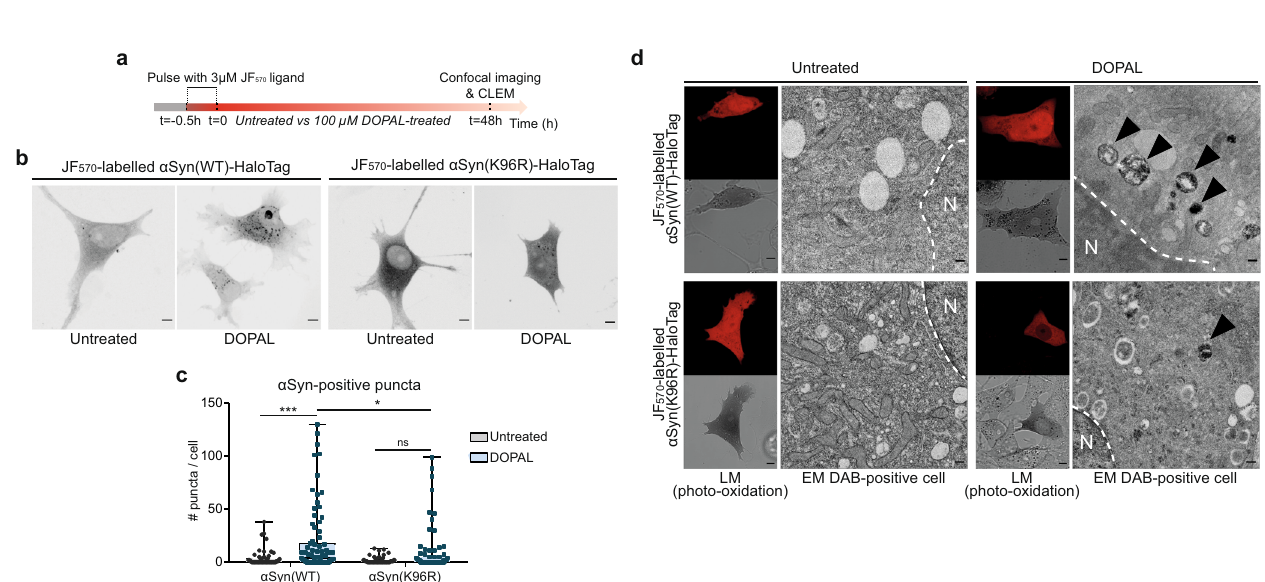
Fig. 5 K96 is required for DOPAL- α Synuclein endo-lysosomal degradation. a Schematic representation of the pulse-chase experiment using the fl uorescent JF 570 HaloTag ligand in α Syn-HaloTag-overexpressing BE(2)-M17 cells. b Representative confocal images of BE(2)-M17 cells expressing α Syn(WT)-HaloTag and α Syn(K96R)-HaloTag, labeled with JF 570 HaloTag ligand, in untreated and 100 μ M DOPAL-treated cells for 48 h. Scale bar: 5 μ m. c Incidence of α Syn-positive cytoplasmic puncta. Data from three independent experiments are pooled together and analyzed by Two-way ANOVA with Sidak ’ s multiple comparison test (* p < 0.05, *** p < 0.001). Data are displayed as box and whiskers plot showing the minimum and maximum points (whiskers), the fi rst quartile, median and third quartile (box lines). d CLEM of BE(2)-M17 cells expressing α Syn(WT)-HaloTag and α Syn(K96R)-HaloTag, following protocol experiment as in ( a ). LM images (confocal and bright fi eld, scale bar: 5 μ m) and corresponding EM micrographs of DAB-positive cells (N: nucleus; scale bar: 200 nm) showing a prevalence of α Syn-positive lysosomal-like structures (black arrows) in DOPAL-treated α Syn(WT)-HaloTag-expressing